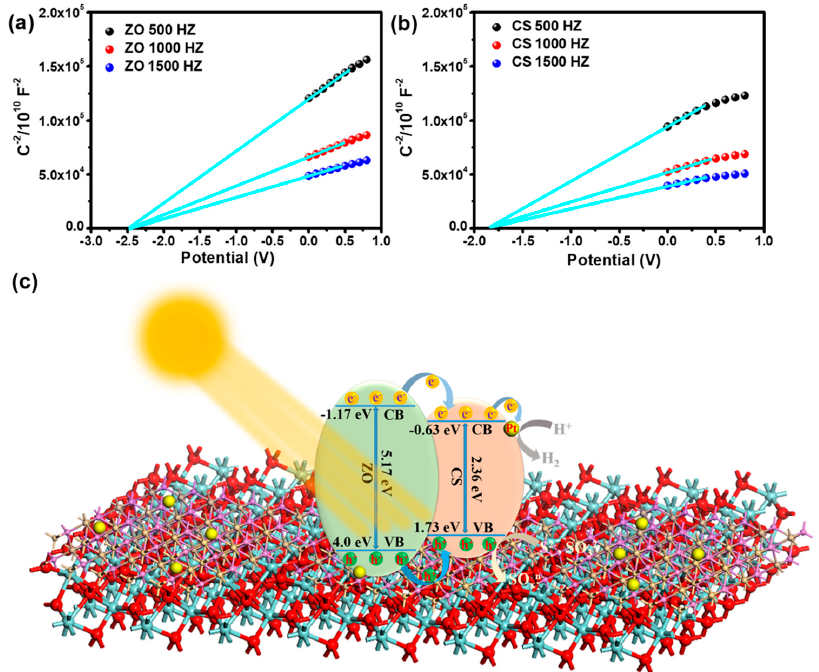
Figure 9. Mott–Schottky plots of ( a ) ZO and ( b ) CS. ( c ) The photocatalysis mechanism of ZO/CS nanocomposite under visible light.